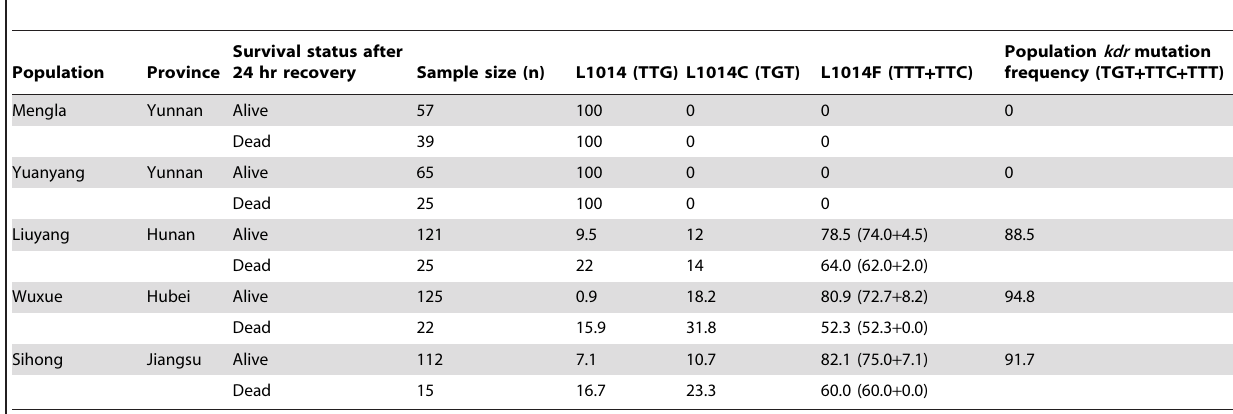
Table 2. Frequencies (in percentage) of kdr alleles in relation to mosquito survival phenotype determined by the deltamethrin susceptibility bioassay in five Anopheles sinensis populations from China.